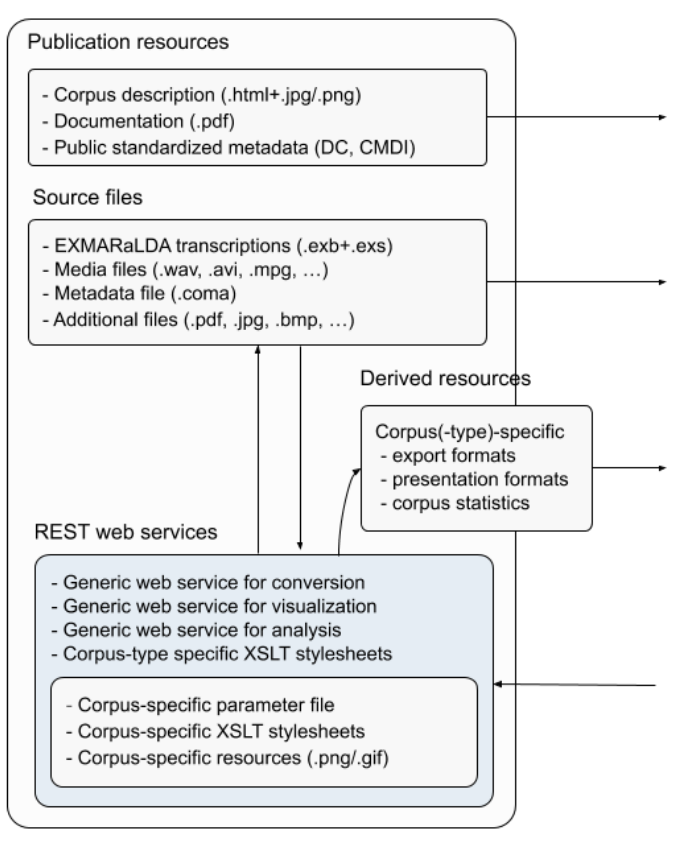
Figure 3. Dynamic repository resource